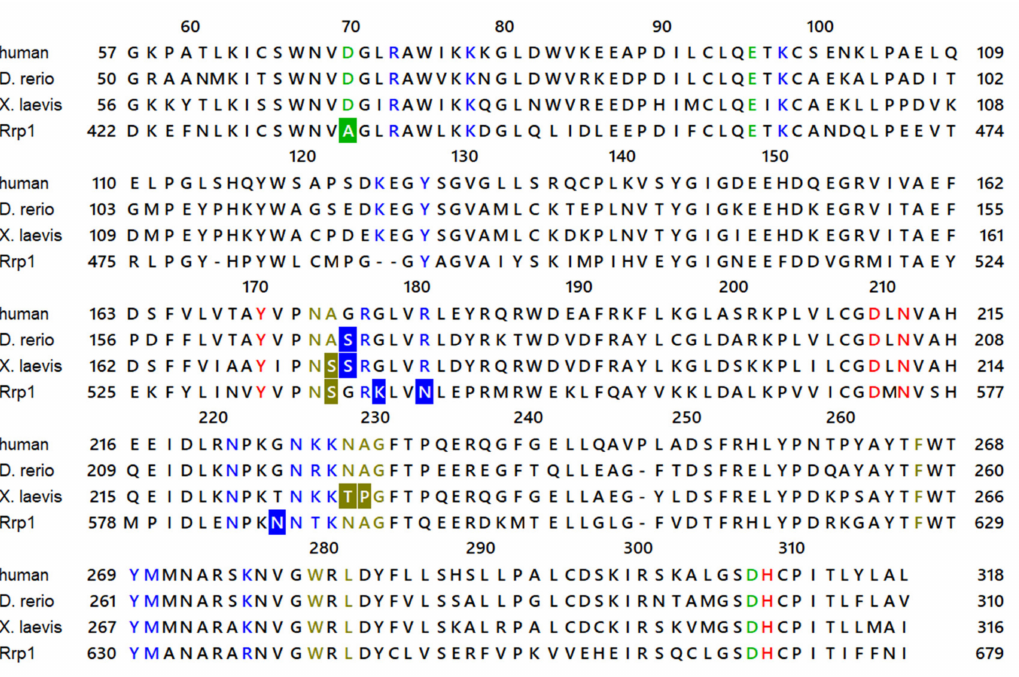
Figure 2. The alignment of the catalytic domain of four APE1-like enzyme sequences. Mg 2+ - coordinating residues are highlighted in green, catalytic residues are red, DNA-binding residues are blue, and active-site pocket residues are yellow. Substitutions that may be important have a colored background. Rrp1 contains one important substitution—D70A—that is known to reduce hAPE1 efficiency, and four alterations (Lys125-, Gly178Lys, Arg181Asn, and Gly225Asn) in the DNA-binding interface. xAPE1 has three substitutions (Ala175Ser, Asn229Thr, and Ala230Pro) at the periphery of the active